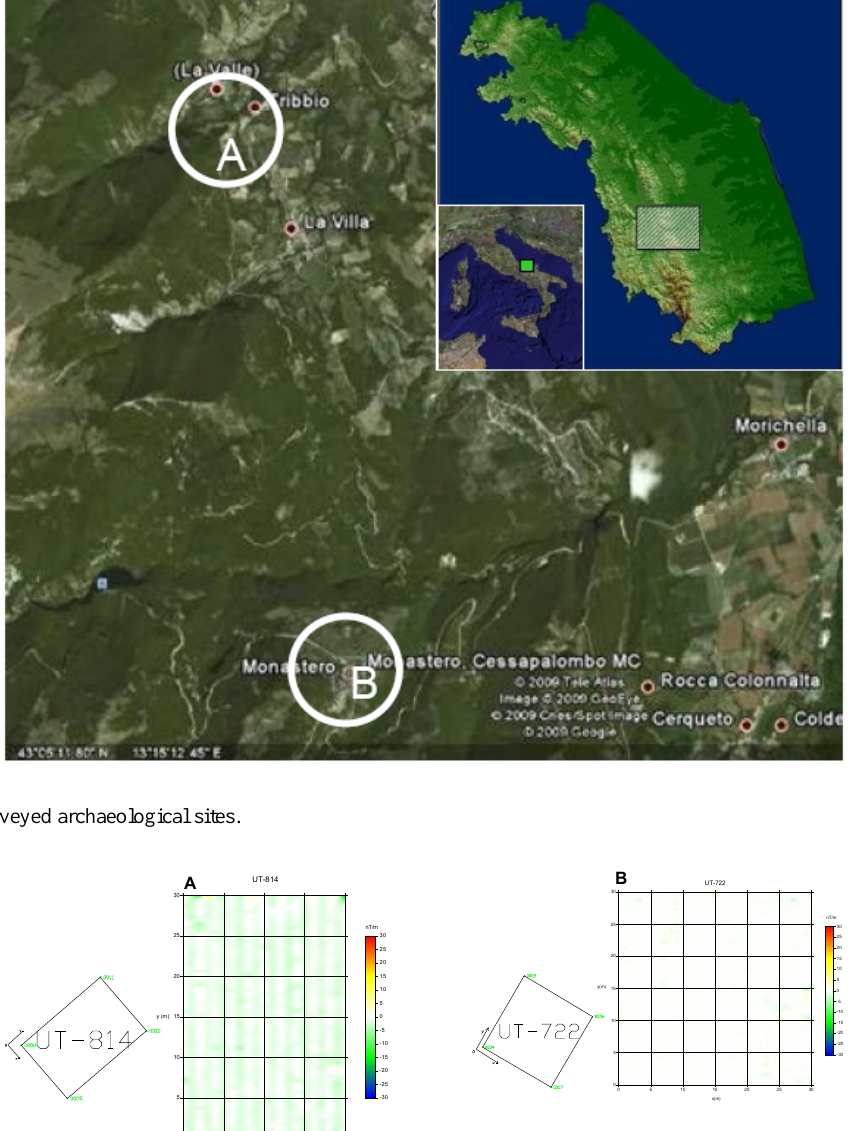
Fig. 1. Location of surveyed archaeological sites.